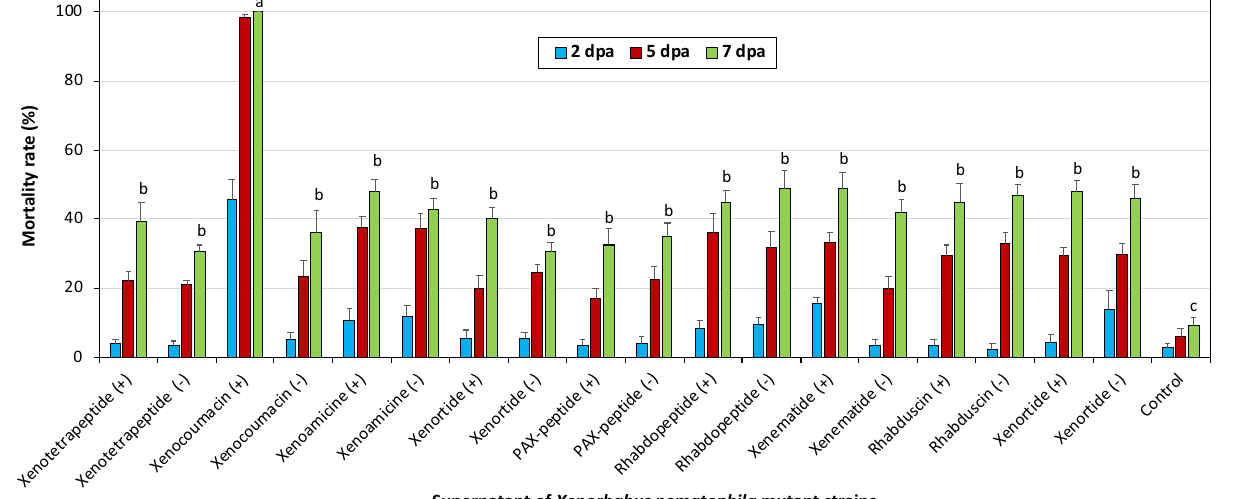
Figure 1. The mortality of induced or non-induced mutant strains of X. nematophila X. nematophila on Tetranychus urticae